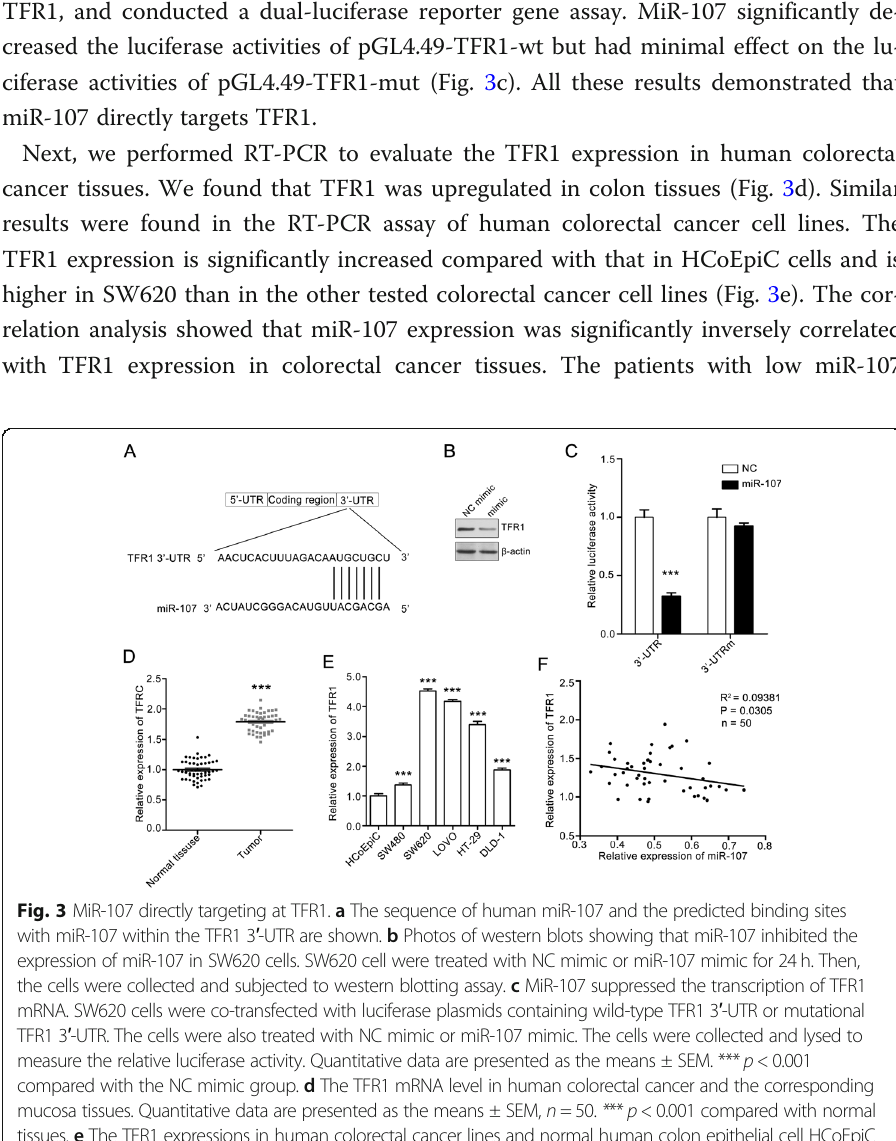
tissues. e The TFR1 expressions in human colorectal cancer lines and normal human colon epithelial cell